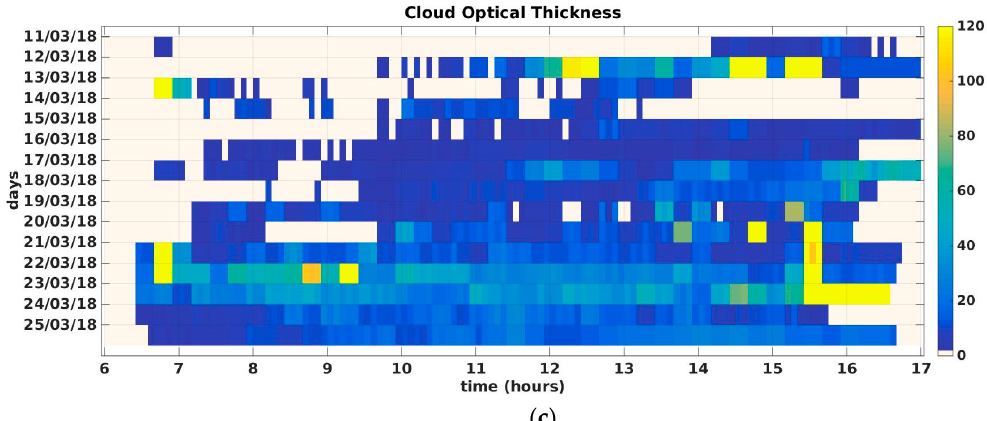
Figure 2. Advanced Model for the Estimation of Surface Solar Irradiance from Satellite (AMESIS)-retrieved microphysical cloud parameters for the whole Tito site dataset, consisting of 12 (samplings) × 10 (hours) × 15 (days). ( a ) Cloud phase histogram. ( b ) Cloud top height. ( c ) Cloud optical thickness. Time is in Coordinated Universal Time (UTC). Empty slots (white color) in ( b , c ) indicate the absence of clouds. Date format is dd/mm/yyyy. Tables 2 and 3 report the statistical scores related to the first site (IMAA/CNR—Tito), located in Southern Italy at an altitude of 763 m. The correlation, MBE, MAPE and MAE, based on the higher sampling frequency, outperform the correspondent statistics based on normal scan SEVIRI images in all cases examined except for MBE on the 17th, 22nd and 24th of March. Table 2. Results of the statistical assessment for AMESIS product based on 15-minute temporal sampling against ground measurements at the Tito site. CORR = Correlation, MBE = Mean Bias Error, RMSE = Root Mean Square Error; MAE = Mean Absolute Error; MAPE = Mean Absolute Percentage Error; nMBE = normalized MBE; nRMSE = normalized RMSE.